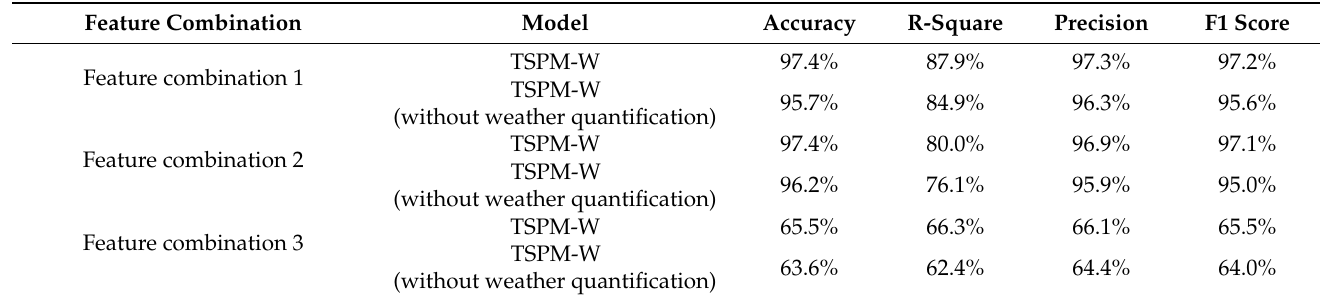
Table 4. Comparison of experimental results of weather feature quantification effect.